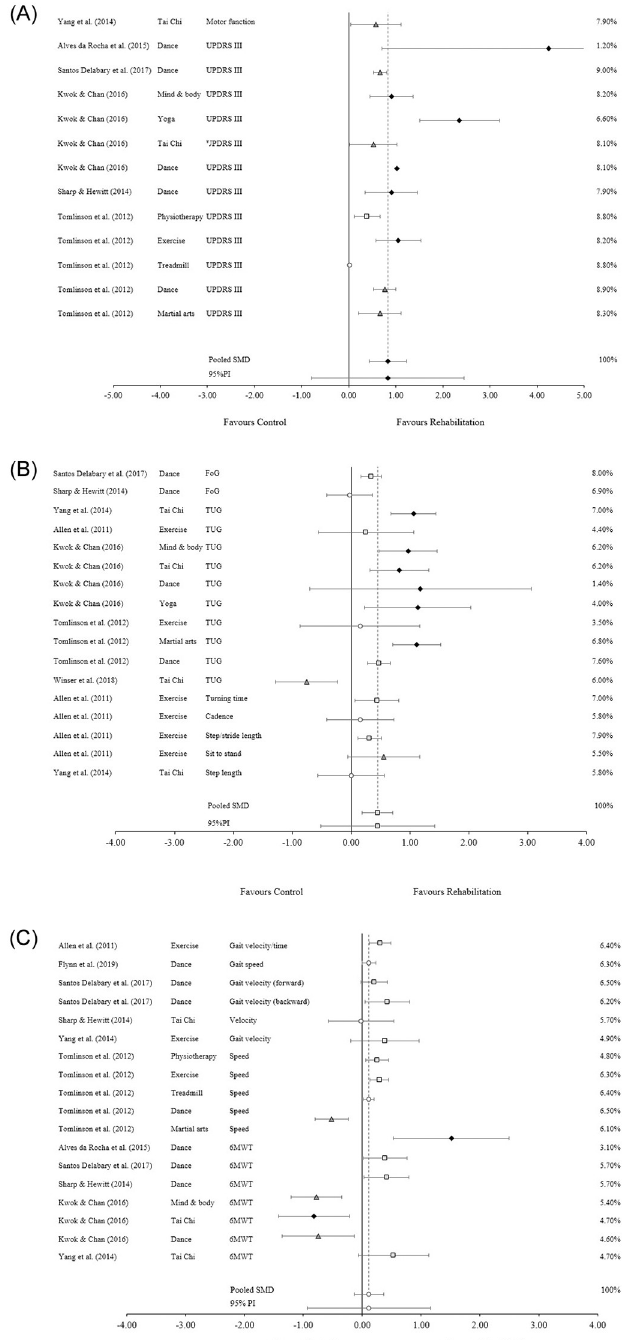
Fig 4. Standardized mean difference (SMD) for motor symptoms. (cid:2) Trivial effect ■ Small effect ▲ Moderate effect ◆ Large effect. Forest plot to illustrate the standardized mean differences (SMD) (95% confidence intervals) for studies evaluating the effect that active rehabilitation has on measures of motor function. Fig 4A is comprised of measures that observed general motor function. Fig 4B is comprised of measures that observed functional mobility. Fig 4C is comprised of measures that observed gait speed and velocity. FoG: Freezing of gait; TUG: Timed up and go test; UPDRS III: Unified Parkinson’s Disease Rating Score Part III (motor); 6mWT: Six-minute walk test.